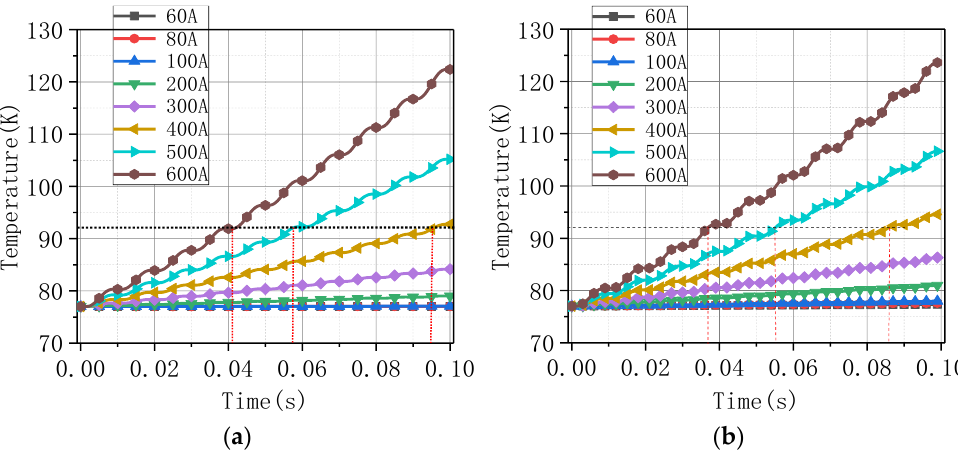
Figure 11. The highest temperature under different current amplitudes: ( a ) Model A; ( b ) Model B. The black dashed line represents the quenched temperature 92 K, and the red dashed lines represent the time used to reach the quenched temperature.